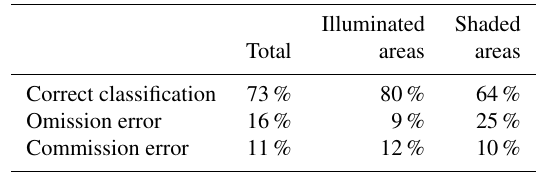
Table 4. Accuracy of the mapped avalanche area.